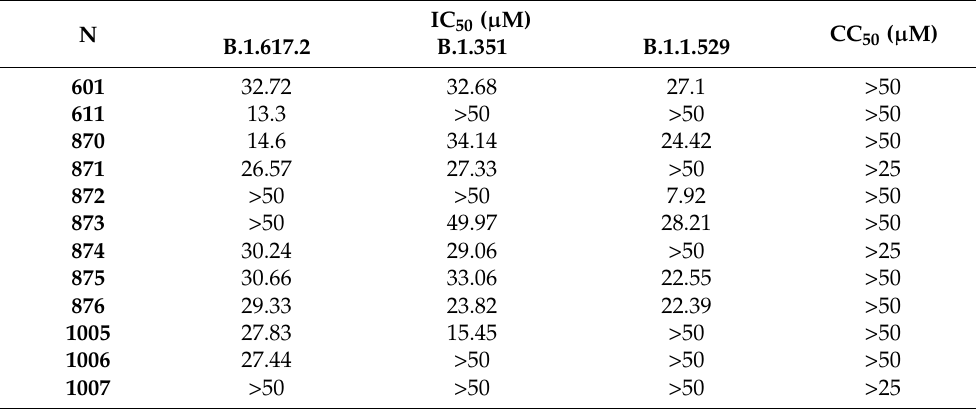
Figure 1. Antiviral Activity of Compounds against ( a ) «Delta» and ( b ) «Beta» Variants of the SARS- CoV-2. Vero E6 Cells were Treated with Various Compound Concentrations and Infected with SARS-CoV-2 at 100 TCID 50 . The virus-induced cytopathic effect (CPE) was measured at 72 h post- infection using the MTT test. Points and error bars represent mean ± SEM of triplicate measurements. Table 1. Values of CC50 and IC50 against SARS-CoV-2 (Delta, Beta and Omicron) Infection of Vero E6